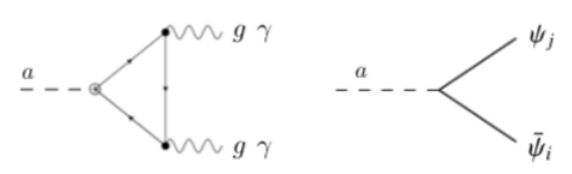
Figure 2. Model-dependent axion couplings to photons and SM quarks and